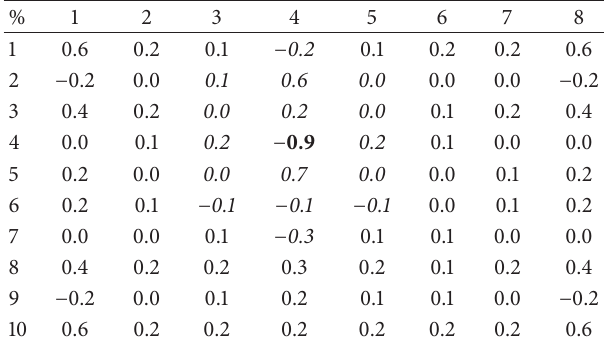
Table 4: Temperature difference (normal versus